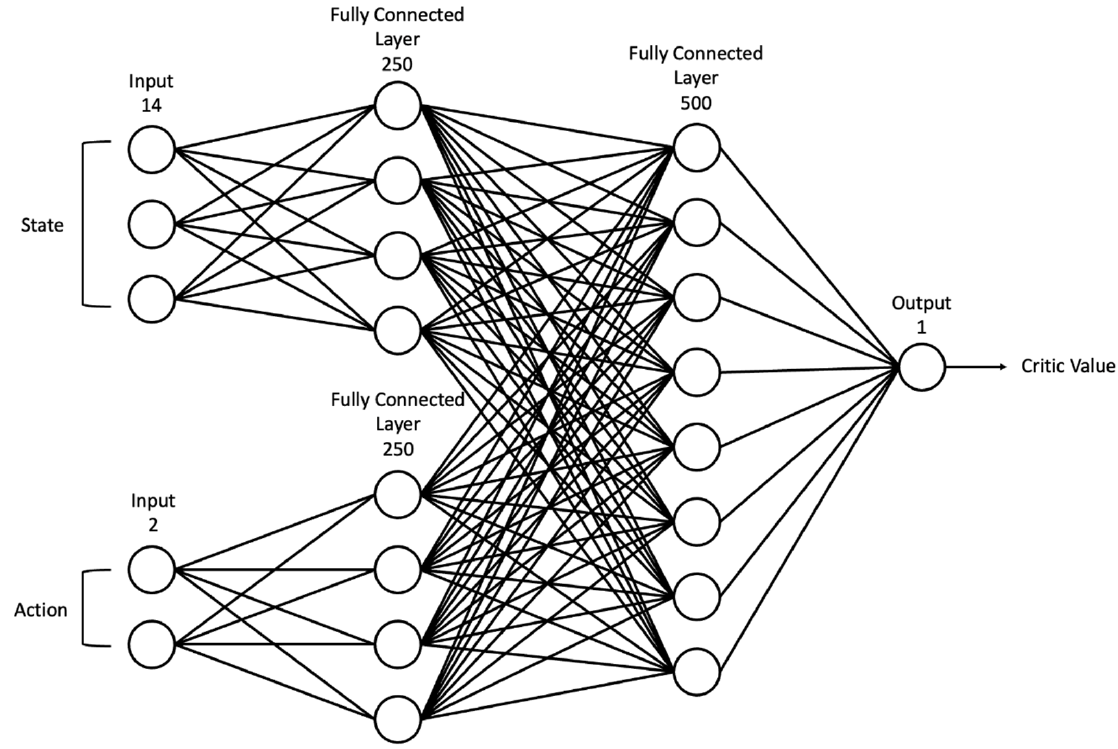
Figure 4. Critic network structure consisting of fully connected layers.